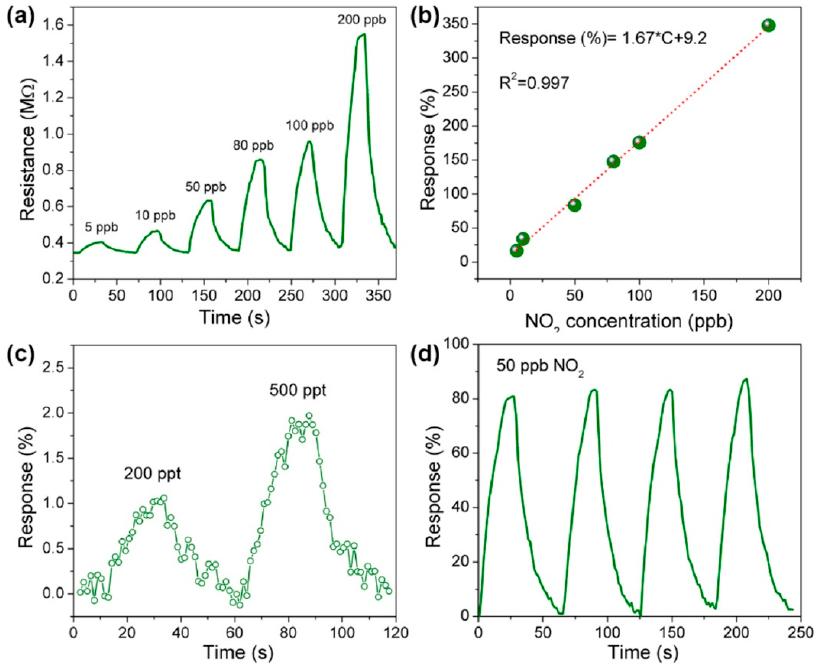
Figure 22. Dynamic response curves ( a ) and responses with linear line fitting ( b ) of the Ti 3 C 2 T x /ZnO-NR-based sensor upon the exposure to NO 2 (5–200 ppb) under UV illumination; ( c ) dynamic response curves of the Ti 3 C 2 T x /ZnO-NR-based sensor upon the exposure to NO 2 (200 and 500 ppt) under UV illumination; ( d ) reproducibility and reversibility of the Ti 3 C 2 T x /ZnO-NR-based sensor upon the exposure to NO 2 (50 ppb) under UV illumination (for 4 successive cycles). Reprinted with permission from [124]. Copyright 2022: Elsevier B.V.